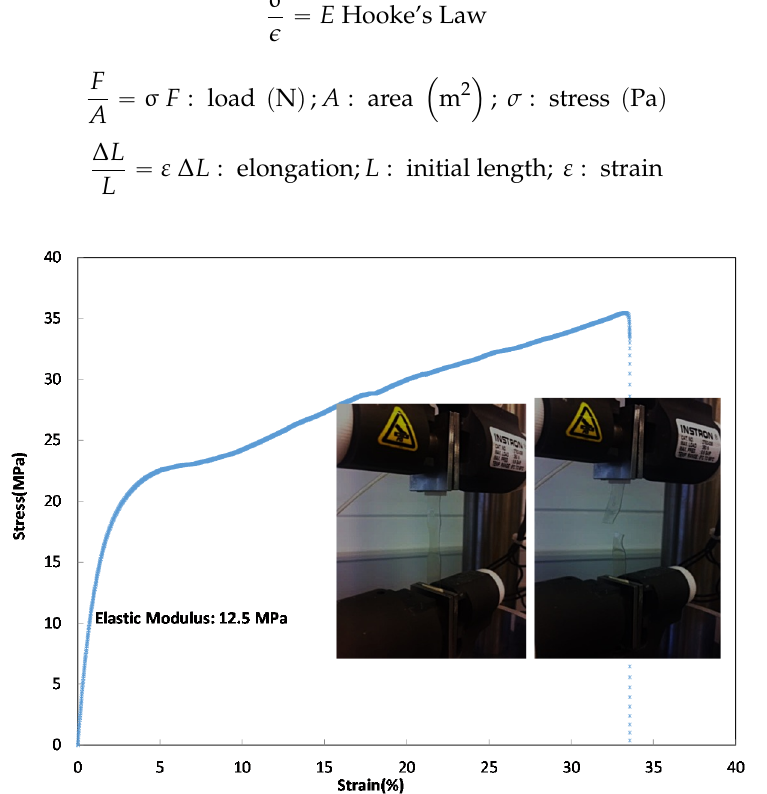
Figure 7. Stress–strain curve of dialyzed and diafiltered keratin film.